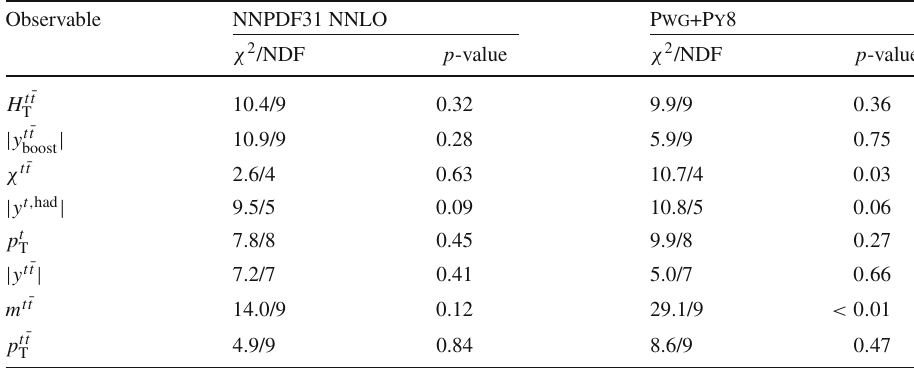
calculated using the covariance matrix of the measured spectrum. The NDF is equal to the number of bins in the distribution minus one